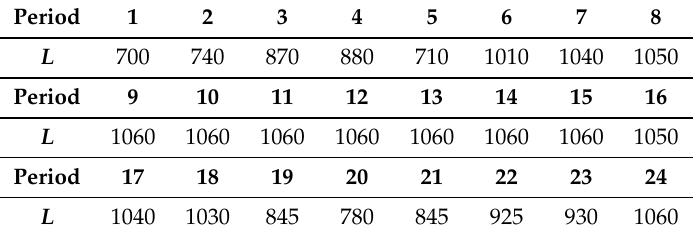
Table 3. Power demands (MW)-scenario 3. Data from [11].